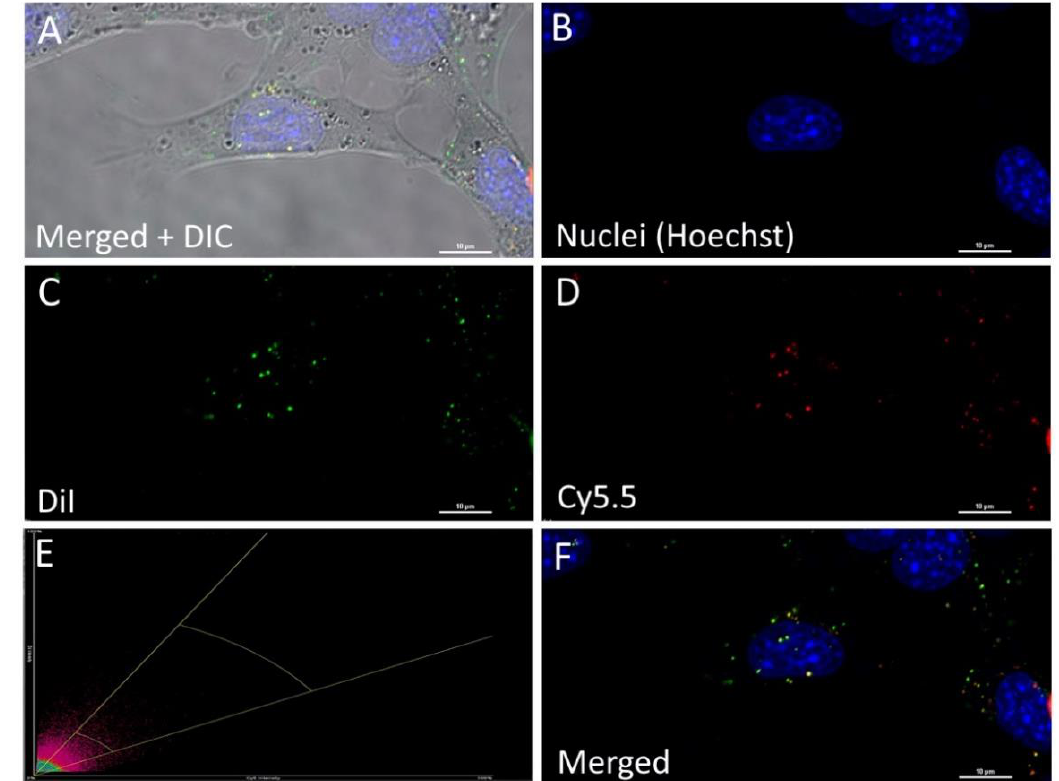
Figure 7. 4T1 murine mammary carcinoma cells after 40 min incubation with the PLGA-Cy5.5/DiI nanoparticles: maximum intensity projection of a z-stack (Laser Scanning Confocal Microscopy, Nikon A1 MP). ( A )—merged image and differential interference contrast (DIC); ( B )—cell nuclei (Hoechst). ( C )—DiI fluorescence; ( D )—PLGA-Cy5.5 fluorescence; €—Scatterplot representing colocalization between DiI and Cy5.5 fluorescent signals. ( F )—Merged image. Scale bar 10 μm.